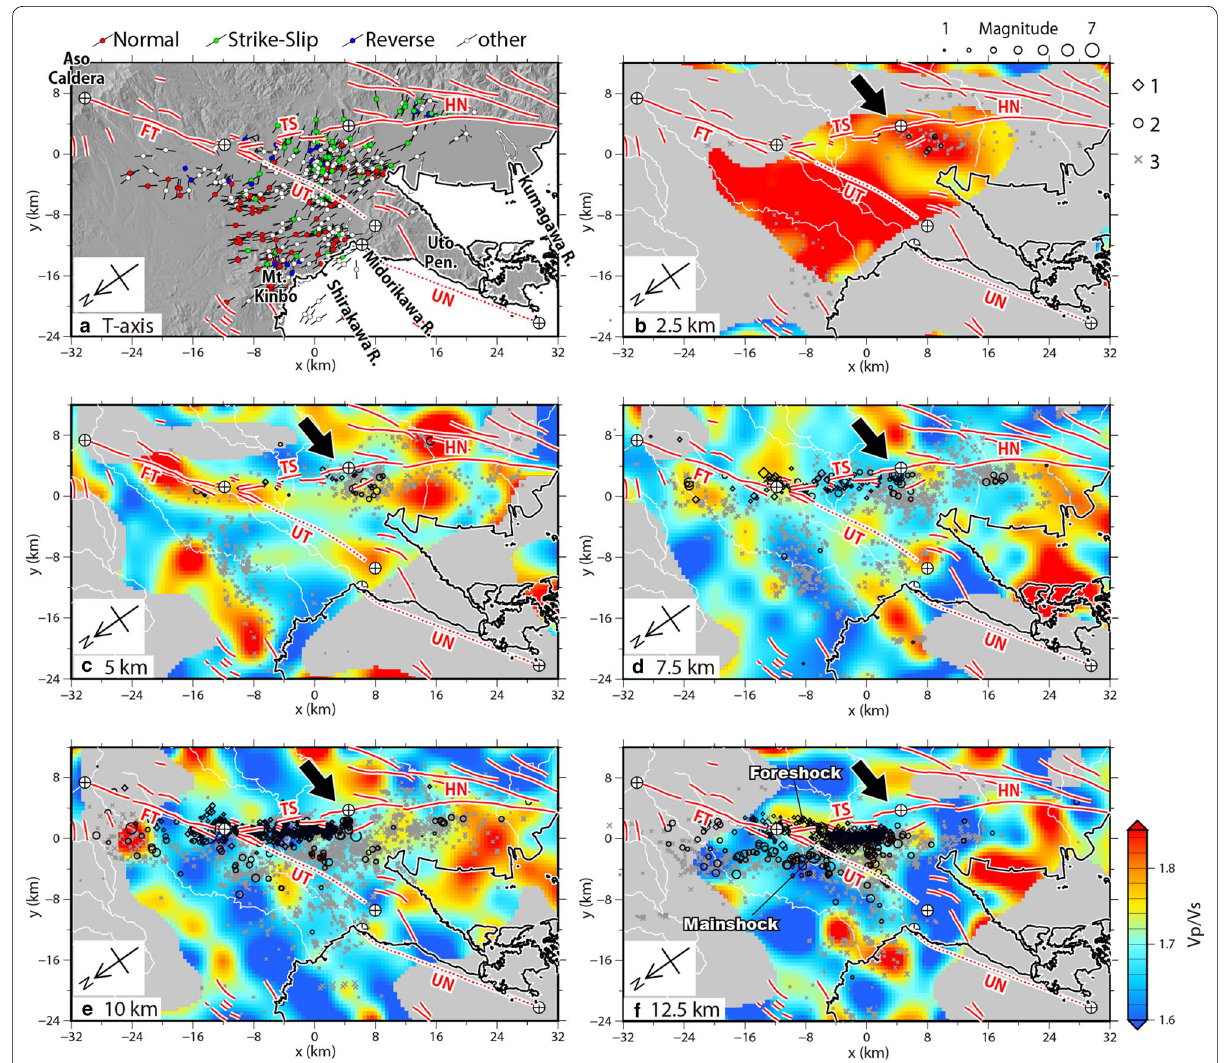
Fig. 6 V p/ V s structure and aftershock distribution in the early stage. a T-axes of the various fault types, and Vp/Vs at b 2.5 km, c 5 km, d 7.5 km, e 10 km, and f 12.5 km depth. The hypocenters located within 2.5 km of each depth slice are plotted and labeled according to their occurrence in the earthquake sequence: 1 from the foreshock to the mainshock; 2 up to one day after the mainshock; 3 April 17–June 30, 2016. The locations for = = = 1–3 are based on the JMA unified earthquake catalog. The solid and dashed red lines denote the active faults determined by RGAF (1991) and HERP (2013), respectively. FT Futagawa segment, UT Uto segment, UN north coast of Uto Peninsula segment, TS Takano–Shirahata segment, HN Hinagu segment. The southern termination of the fault rupture, which is estimated during our study, is indicated by the black